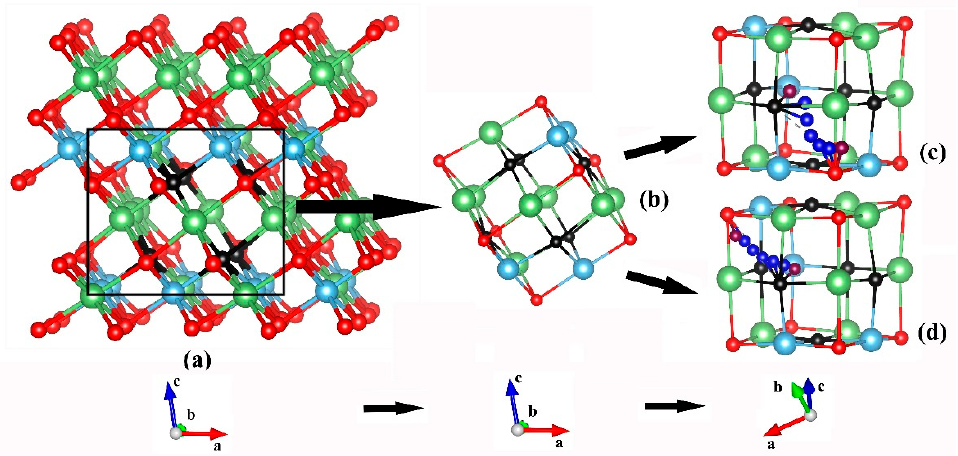
Figure 5. ( a ) shows the relative position in the crystal of the vacancy structure of ( b ) (color online). ( c , d ) The diffusion profile of part III diffusion away from the type B Li vacancy to the crystal in directions of [001] and [010],